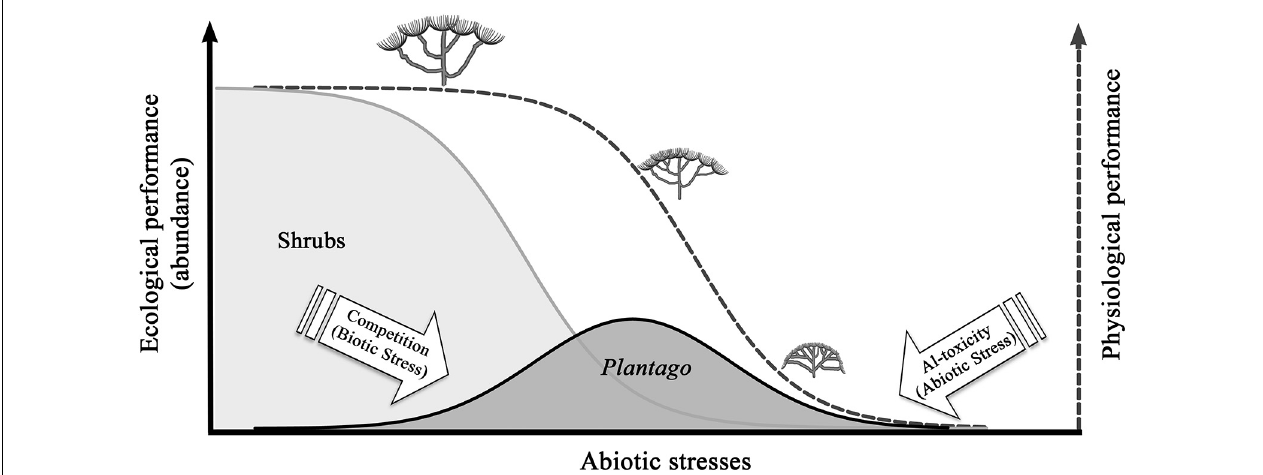
FIGURE 1 | Hypothetical realized niche for Plantago almogravensis ( Plantago ). Filled line : ecological performance of P. almogravensis and of the shrub community along the abiotic stress gradient; dashed line : physiological performance of P. almogravensis , in the absence of competition, along the abiotic stress gradient. The plant schemes represent P. almogravensis morphotypes, from good fitness ( left ) to increased ramification and nanism in areas of more abiotic stress ( right ). Adapted from Serrano (2015), p. 152.